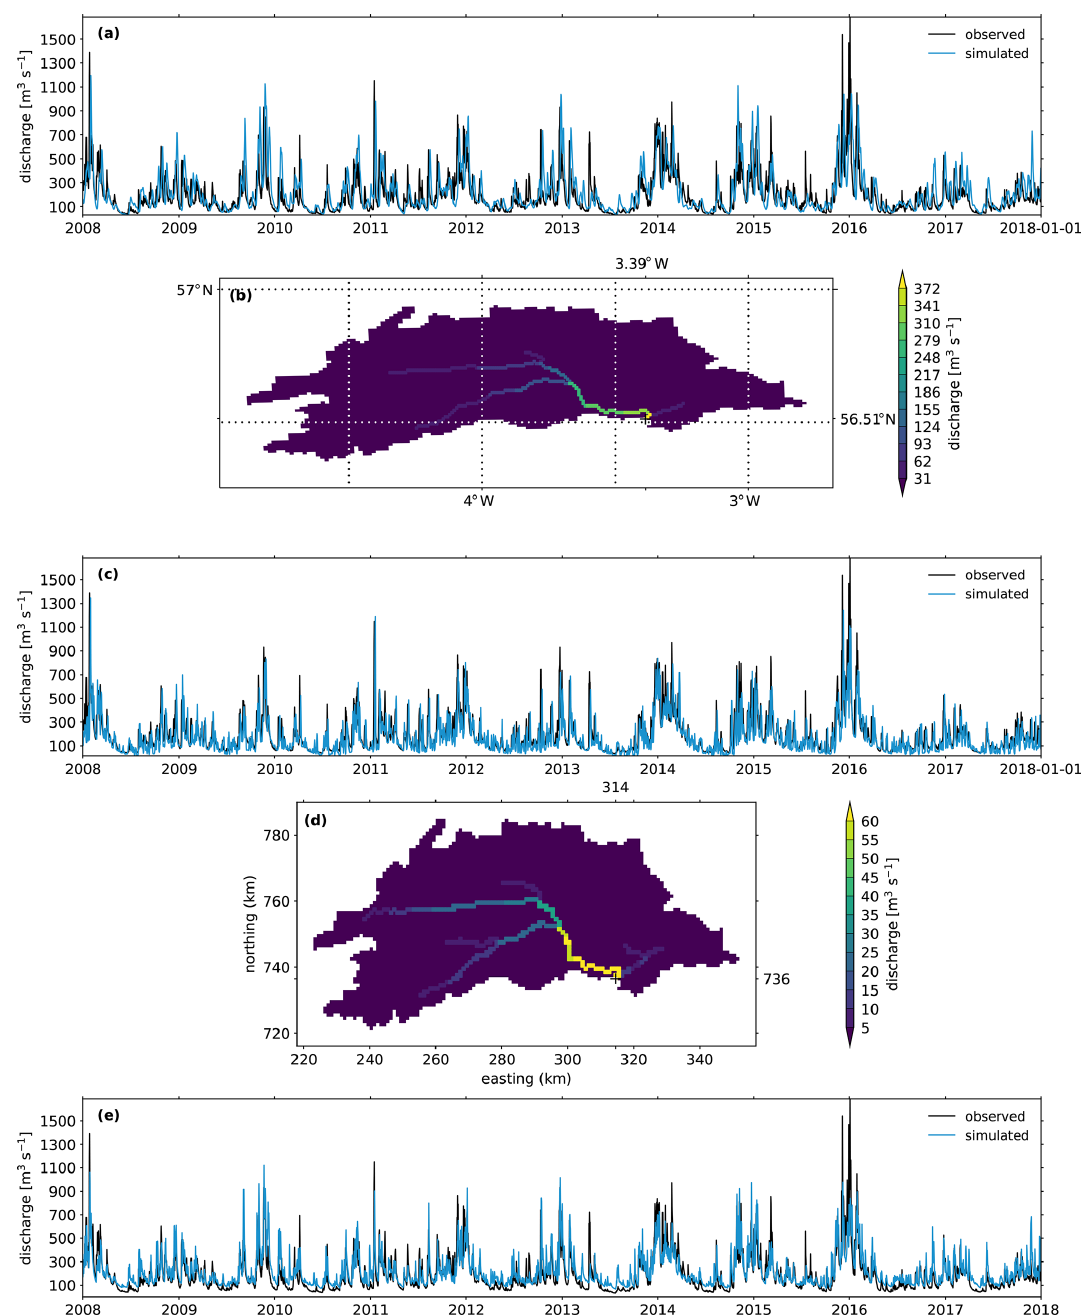
Figure 5. Simulation of the river discharge with the three configurations for the Tay catchment: (a) observed and simulated hydrographs with configuration 1 at the catchment outlet (3.39 ◦ W, 56.51 ◦ N), (b) gridded simulated discharge with configuration 1 for the last simulation step (1 January 2018), (c) observed and simulated hydrographs with configuration 2 at the catchment outlet (314, 736), (d) gridded simulated discharge with configuration 2 for the last simulation step (1 January 2018), (e) observed and simulated hydrographs with configuration 3 at the catchment